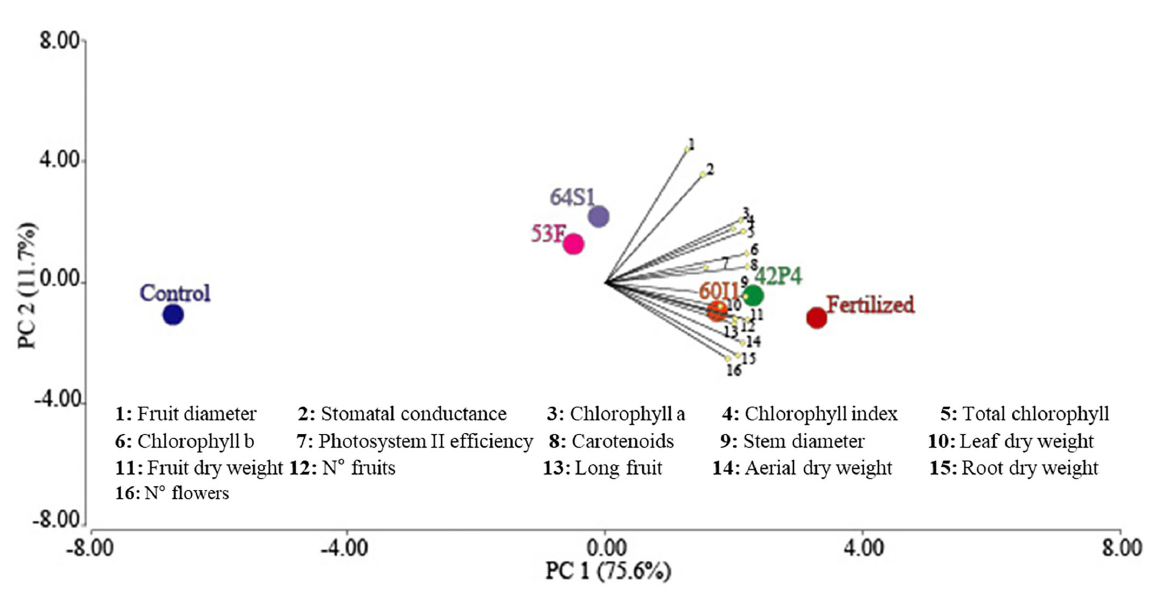
of total phenolic acids (39.63 mg g − 1 ), followed by Fertilized, Control, and 60I1 (35.96, 9.14, and 5.50